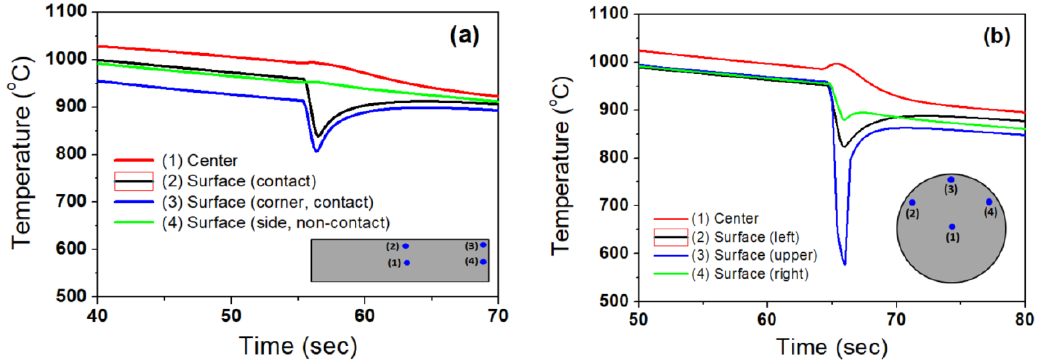
Figure 5. Measured temperature profiles of ( a ) the plate during flat rolling and ( b ) the rod during shape rolling with area.